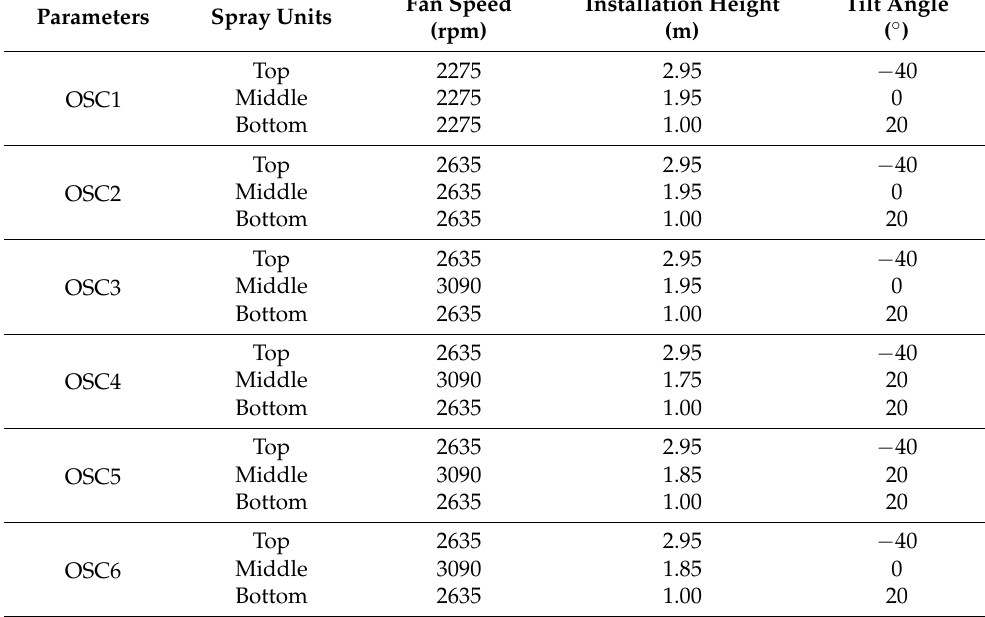
Table 2. The test parameters of MAS used in spray